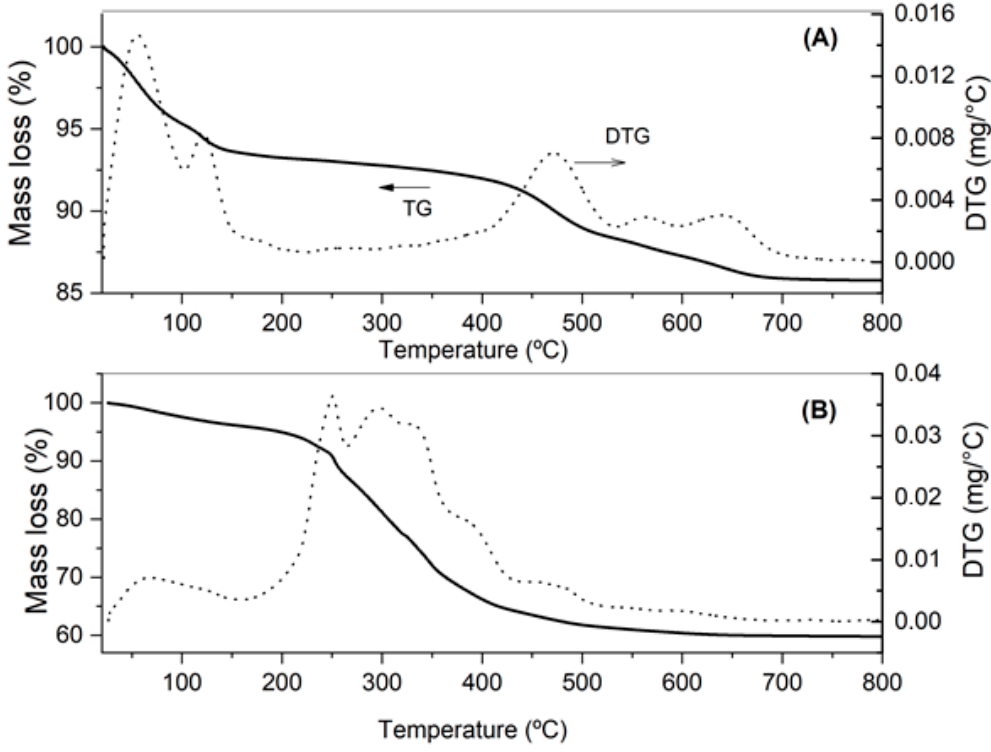
Figure 2. TG / DTG curves of clay before ( A ) and after ( B ) palm oil bleaching. Figure 2. TG/DTG curves of clay before ( A ) and after ( B ) palm oil bleaching.